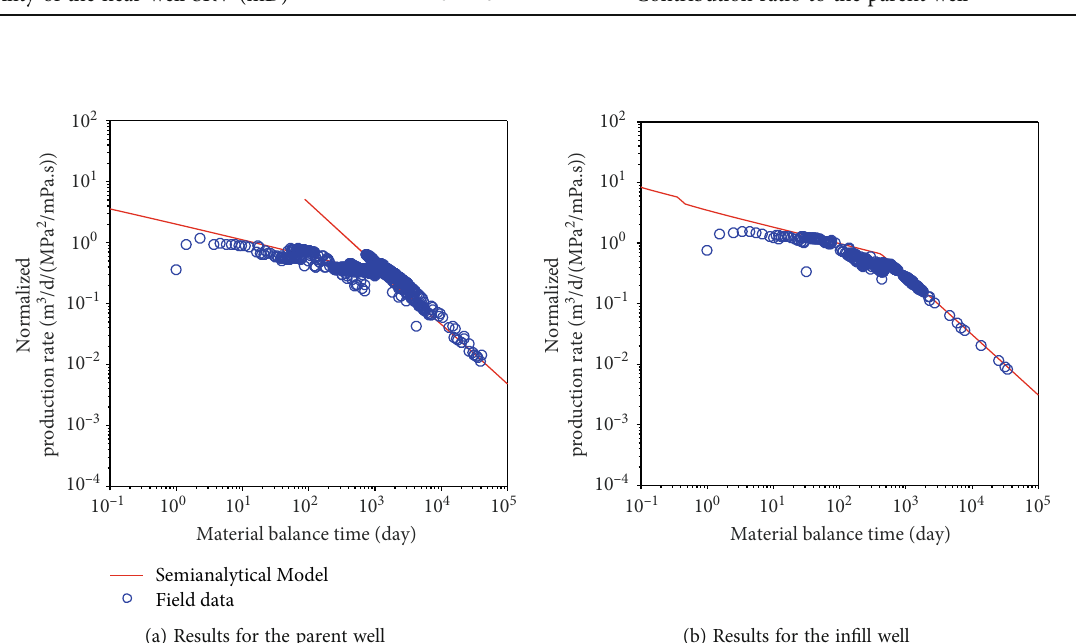
Figure 12: The production analysis results for the parent and in fi ll